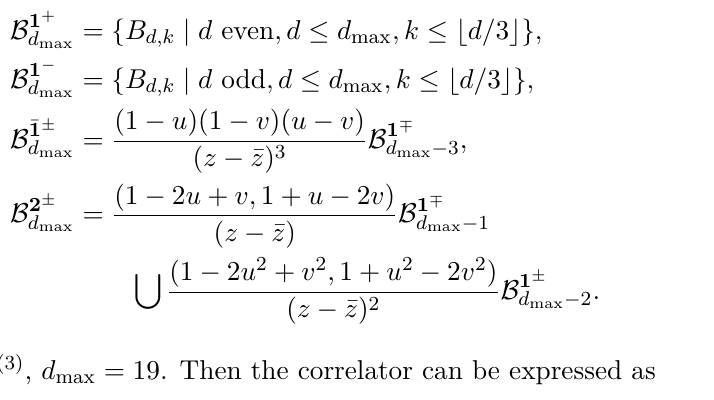
Table 2 . Number of independent SVMPL functions with fixed weight w and fixed S 3 × Z 2 repre- sentation that appear in the final result for the graviton scattering at two loops. a basis B r for d max